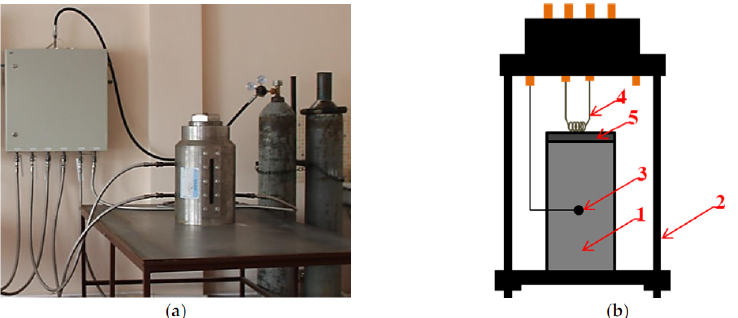
Figure 1. ( a ) Image of the constant pressure reactor, ( b ) a schematic of sample placement in the reactor: 1, the sample; 2, the reactor rack; 3, VR–20/5 thermocouples (Ø–500 µ m); 4, the igniting molybdenum spiral; and 5, the igniting